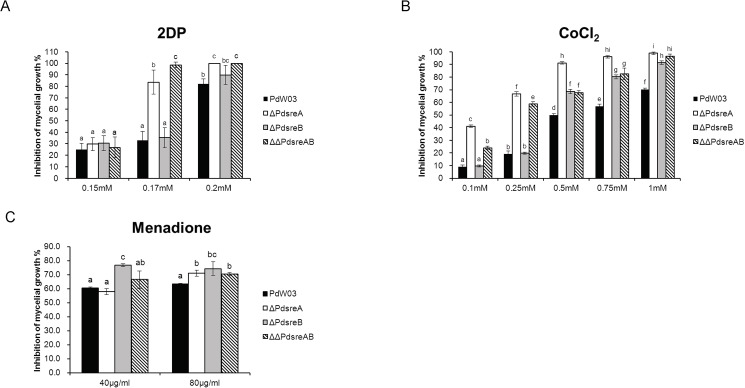
Sensitivity of the wild-type PdW03 and the SREBP mutants to different chemical agents.(A) Inhibition of mycelial growth by iron chelator 2,2-dipyridyl (2DP) at the concentrations indicated in the figure. (B) Fungal growth on PDA medium with serial concentrations of CoCl2. (C) Fungal growth on PDA medium amended with menadione. All plates were incubated for 5 days at 25°C. Different letters are used to mark statistically significant differences from one another (P<0.05).